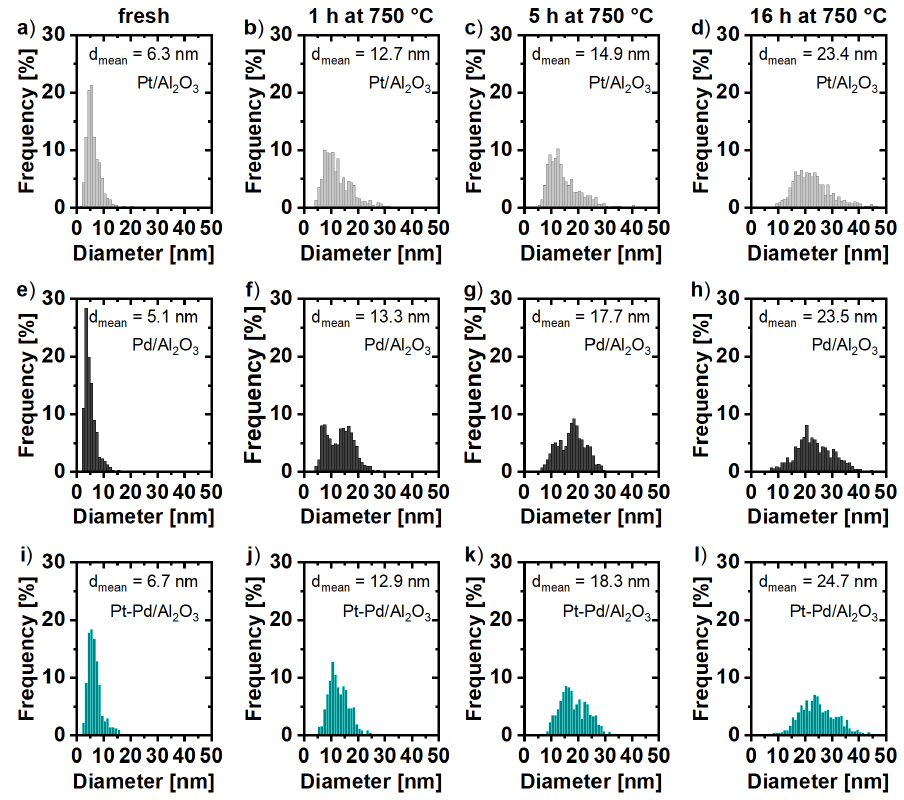
Figure 2. Particle size distribution for Pt/Al 2 O 3 ( a – d ), Pd/Al 2 O 3 ( e – h ), and Pt-Pd/Al 2 O 3 ( i – l ) in the fresh state and after hydrothermal aging for 1 h, 5 h, and 16 h. Table 1. Mean noble metal particle size during the course of the aging experiment obtained by scanning transmission electron microscopy (STEM) analysis of approximately 650 particles and calculated according to Equation (1) based on the dispersion values obtained by means of CO chemisorption. Mean Particle Size